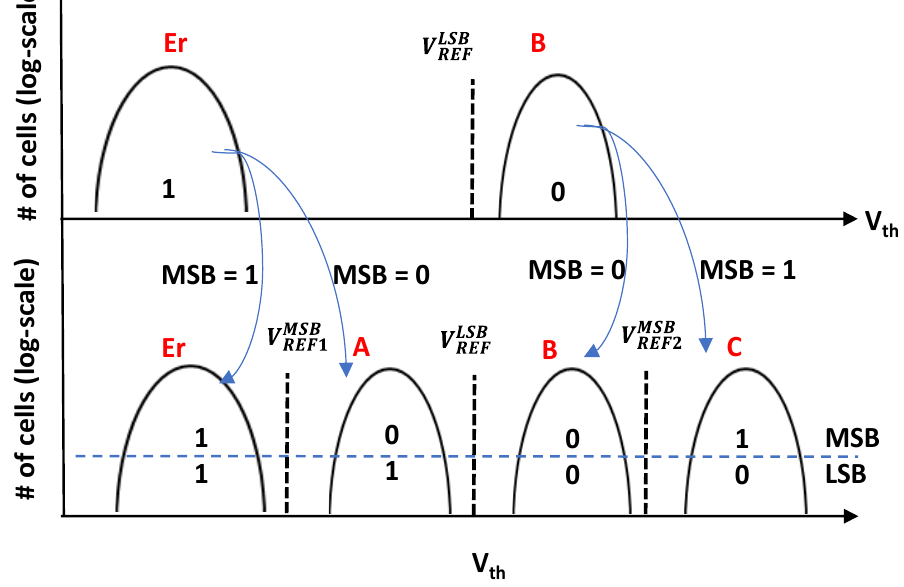
Figure 7. V t distribution for four states in MLC mode. The top distributions show the V t states after LSB page program, and the bottom plot shows the complete distribution after MSB page program.